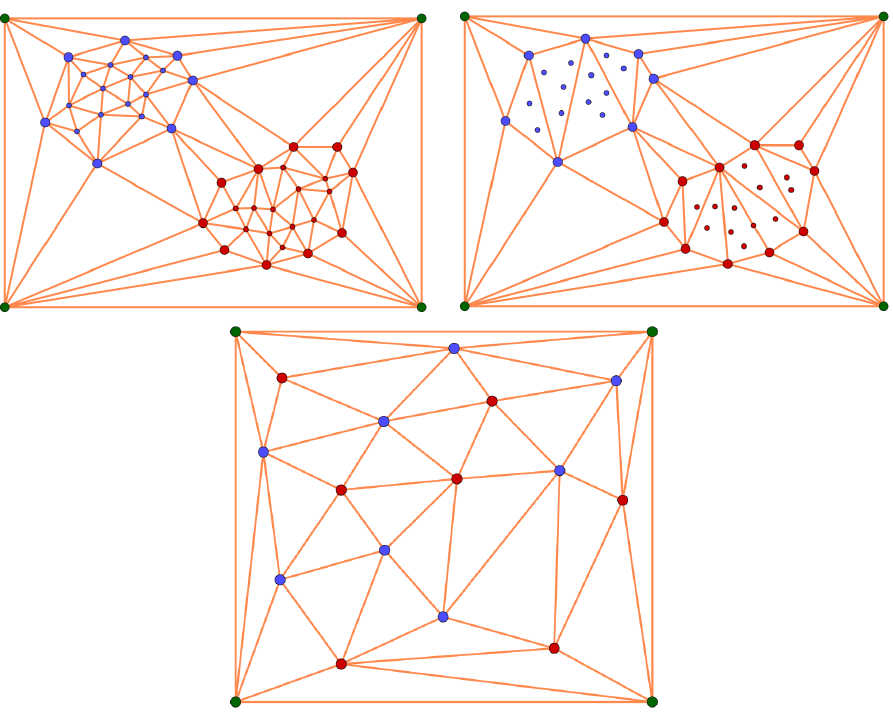
Figure 3. From left to right and from top to bottom: (1) a separable and dense binary data set D ; (2) the data set obtained after applying Algorithm 1 to D ; (3) a data set that cannot be reduced by applying Algorithm